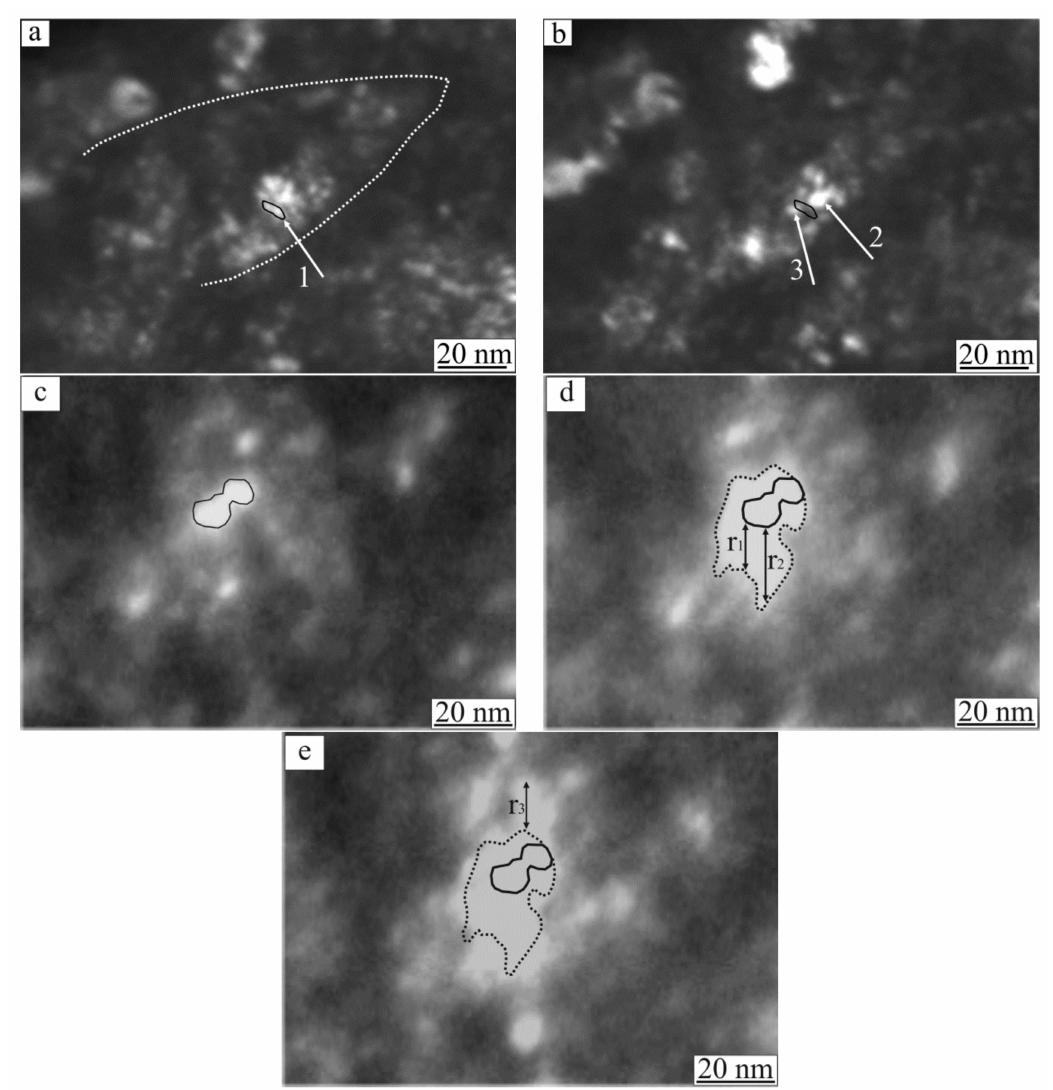
Figure 13. Dark-field images of extinction contour displacement in the bulk of the submicrocrystalline structure under the indenter’s tip: ( a , b ) dipole misorientation of the crystals: a —sample angle tilt 0 ◦ , b —sample angle tilt 0.3 ◦ ; ( c – e) the relaxed structure state: c —sample angle tilt 0 ◦ , d —sample angle tilt 0.3 ◦ , e —sample angle tilt 0.6 ◦ (see explanation in